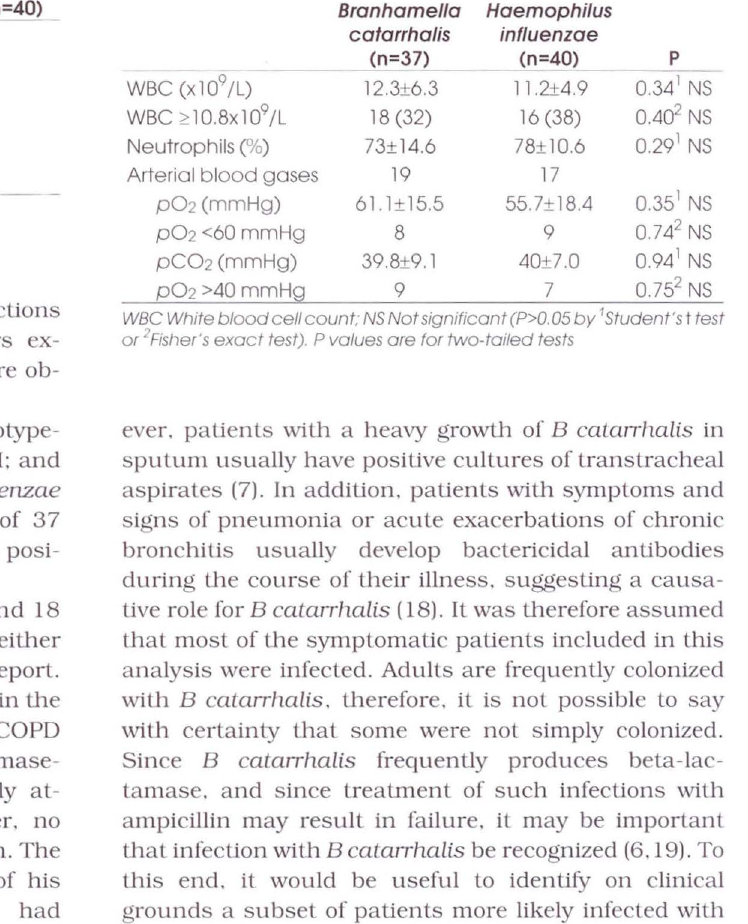
Respiratory infections produced by Branhamel/a catar rha/is and Haemophilus influenzae